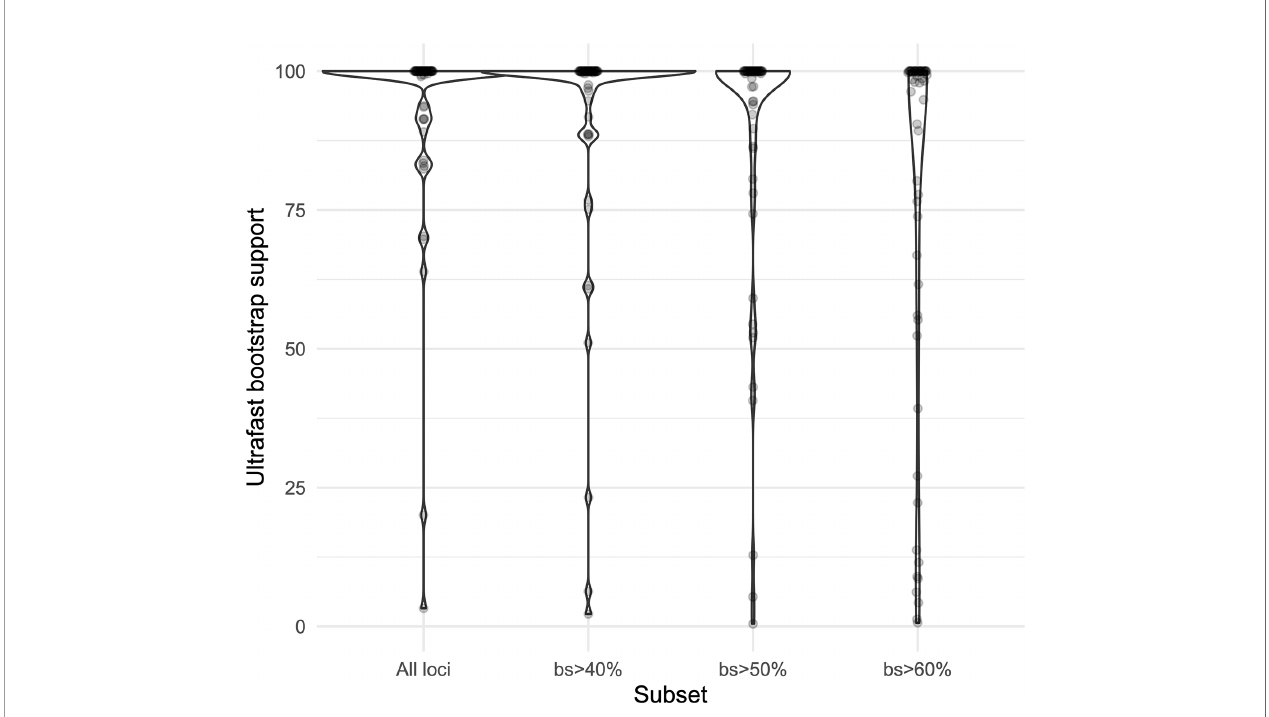
FIGURE 4 | Violin plots comparing the ultrafast bootstrap support values obtained with the concatenation of all the loci and the different subsets in